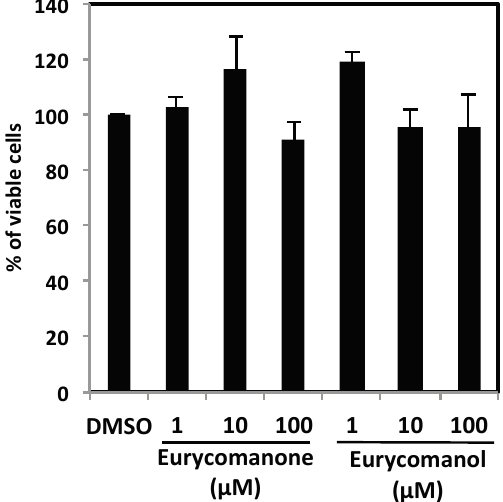
Figure 6. The effect of eurycomanone and eurycomanol on the viability of healthy cells. PBMCs from healthy donors were treated with indicated concentrations for 24 h. DMSO corresponds to solvent-treated control. Each value is a mean ± SD of at least three independent